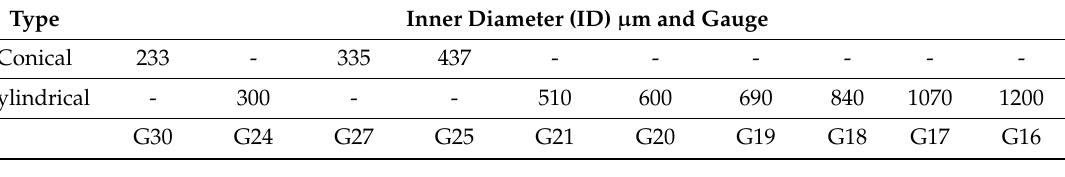
Table 1. The conical and cylindrical nozzles utilized in the experiments with their corresponding gauge and inner diameter (ID).